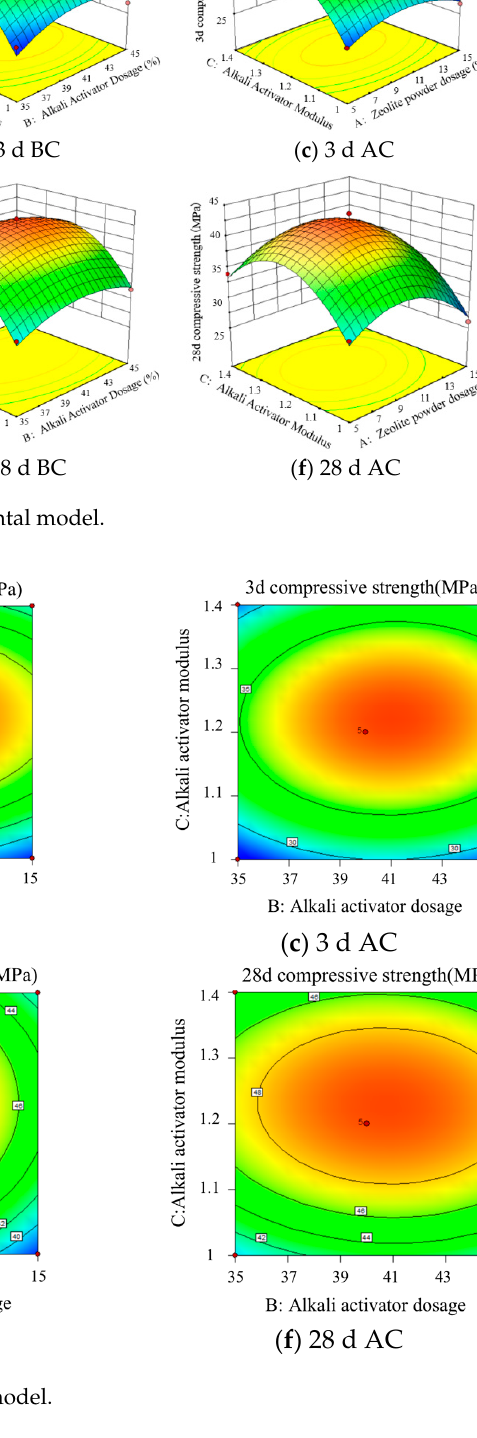
Table 7. Mechanism analysis test group.